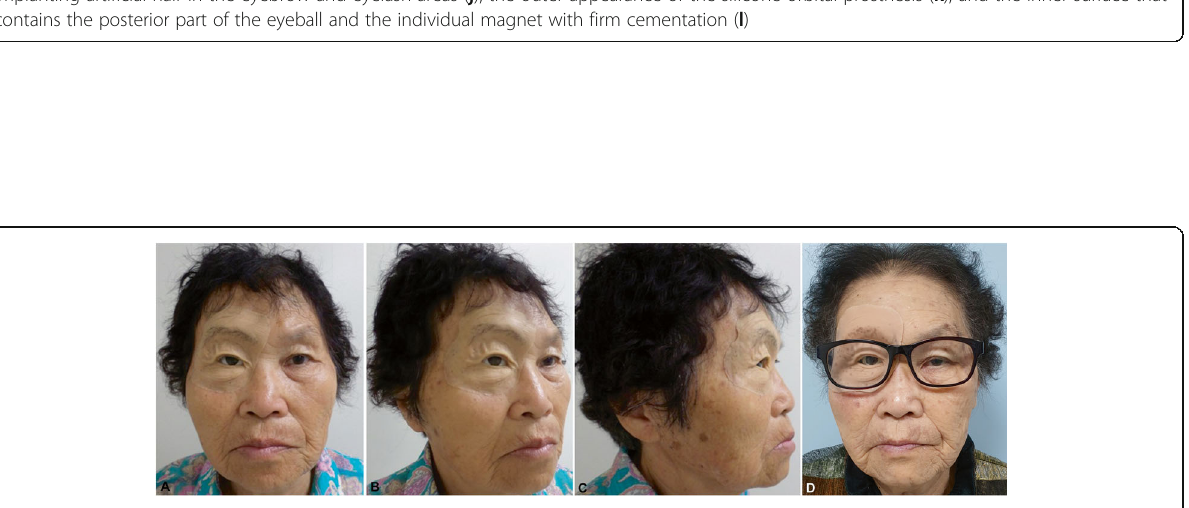
Fig. 4 Clinical facial views of the patient with the final silicone orbital prosthesis, frontal ( a ), oblique semi lateral ( b ), lateral ( c ), and eyeglass frontal views ( d ) 4 weeks later